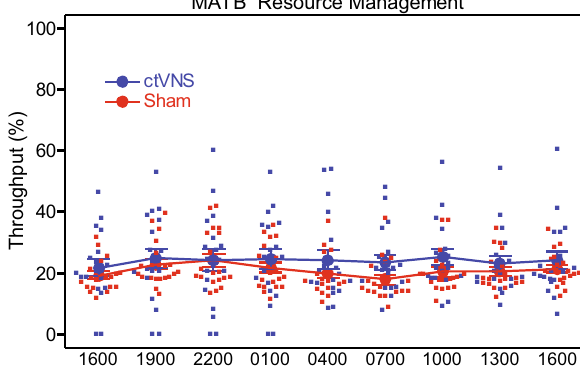
Fig. 4 AF-MATB subtasks: communication, targeting, and resource management. a AF-MATB communication subtask throughput capacity percentage. b AF-MATB targeting subtask throughput capacity percentage. c AF-MATB resource management subtask throughput capacity percentage. For graphs a – c, error bars are mean + / –